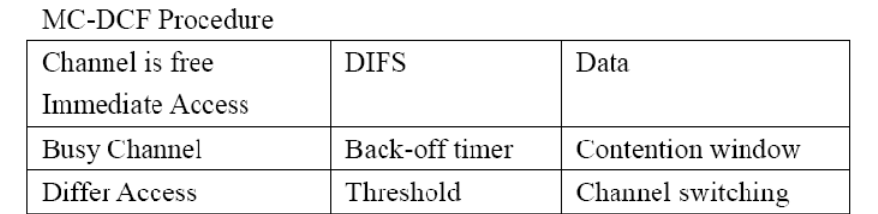
Figure 1. MC-DCF